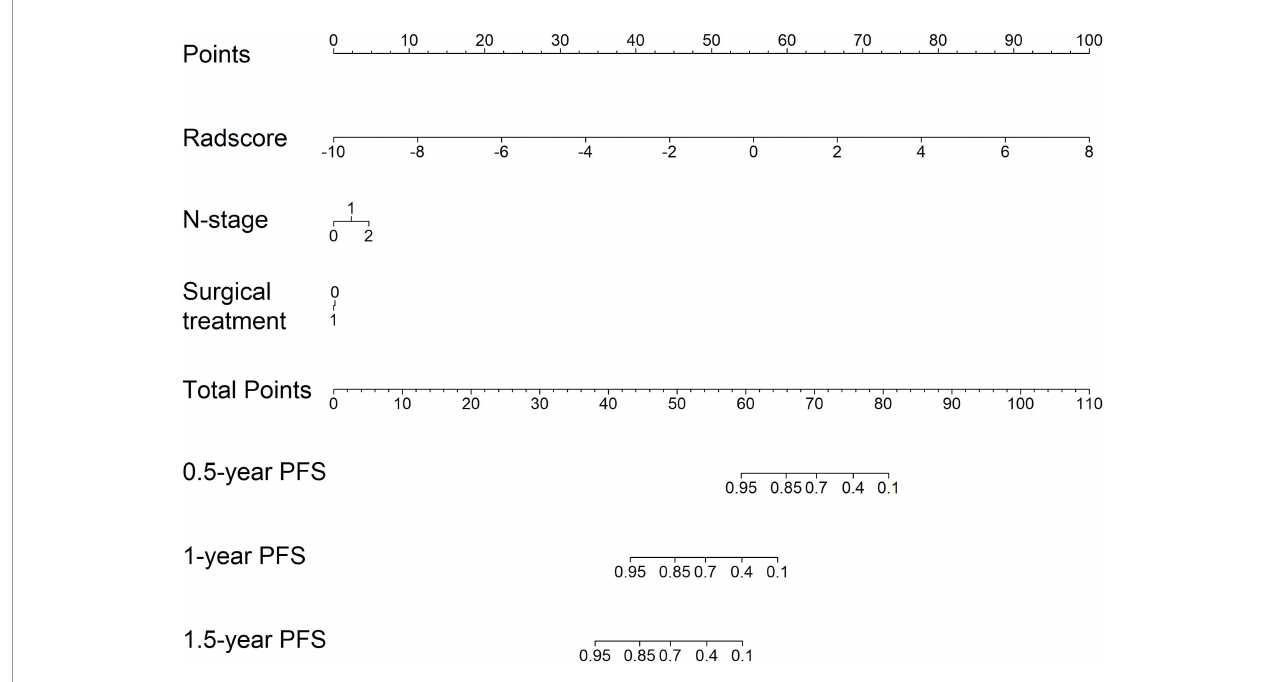
FIGURE 5 | The nomogram for PFS probability prediction based on CombDeltaRad